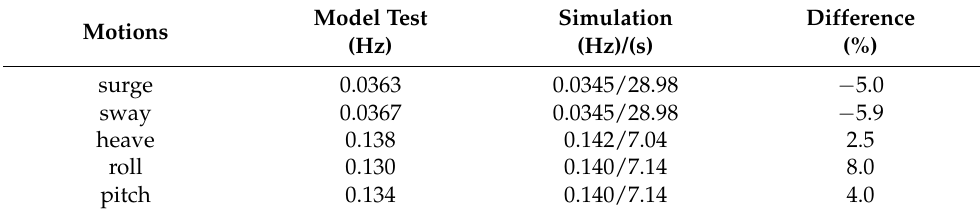
Table 9. Natural frequency of mooring buoy system for uncoupled